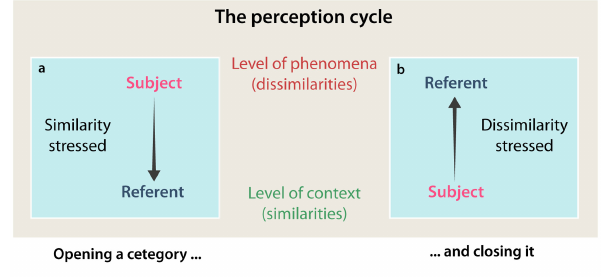
Fig. 2 . Category formation according to Tverski and Gati 1978 (illustration from van der Leeuw